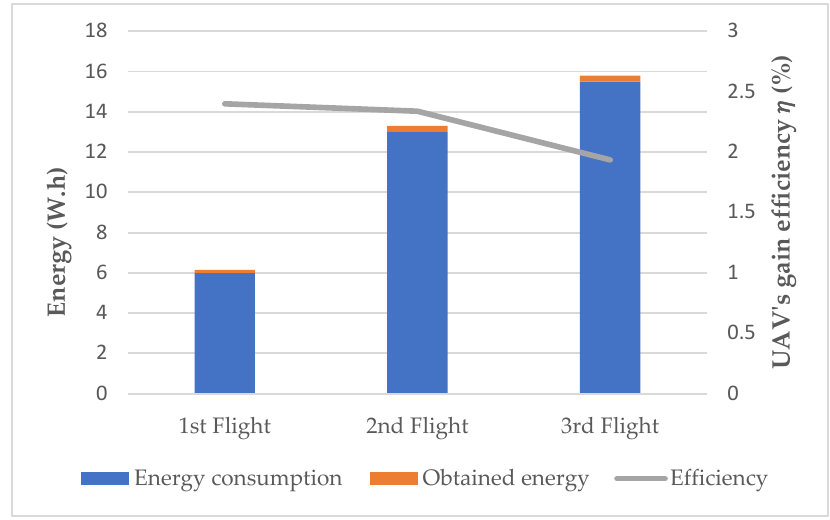
Figure 29. Energy consumption, energy conversion, and gain efficiency of the UAV.